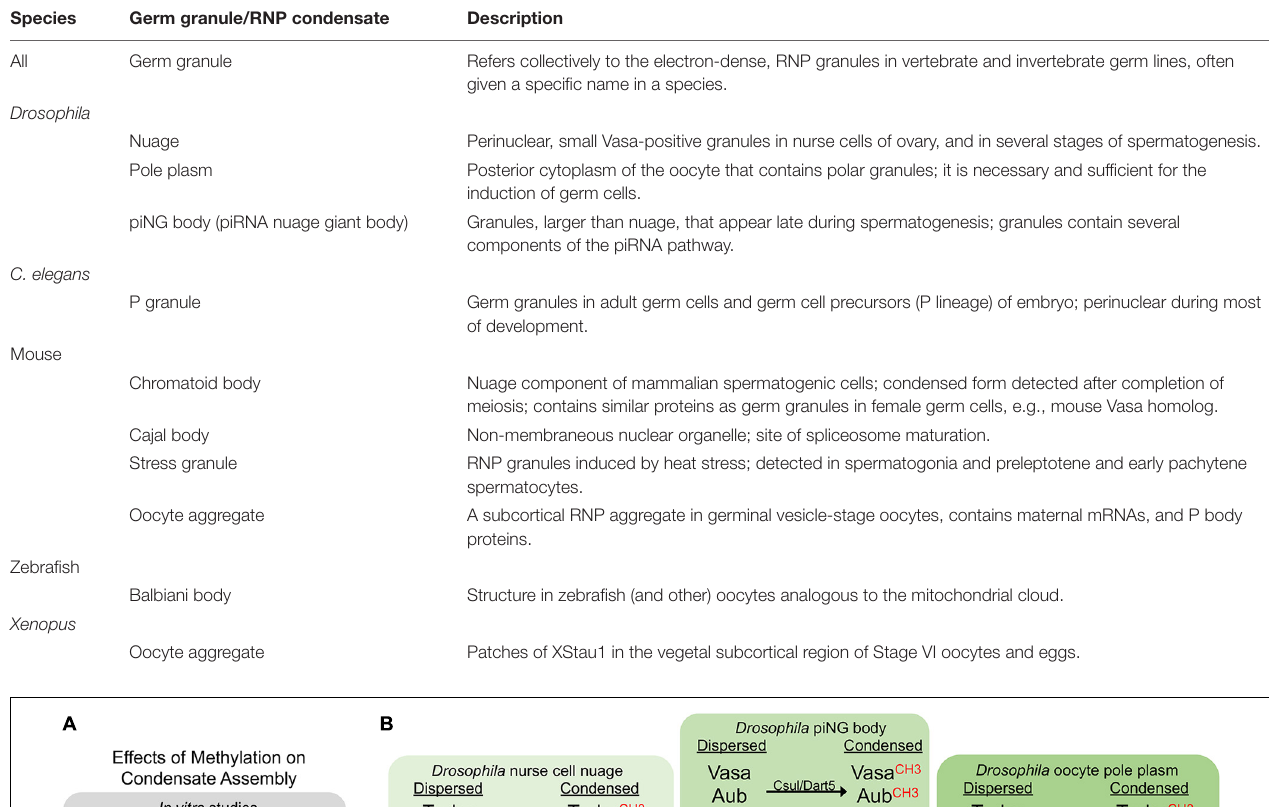
TABLE 1 | Summary of germ line RNP condensates described in this review. Species